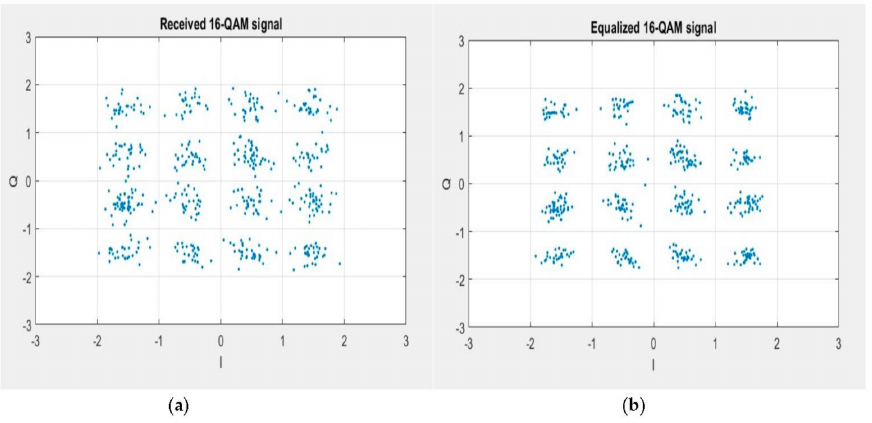
Figure 10. EVM measurements for 16QAM modulation using LMS equalization (50 km SMF link). ( a ) Constellation diagram for 16QAM before equalization with EVM 15.1%. ( b ) Constellation diagram for 16QAM after LMS equalization with EVM